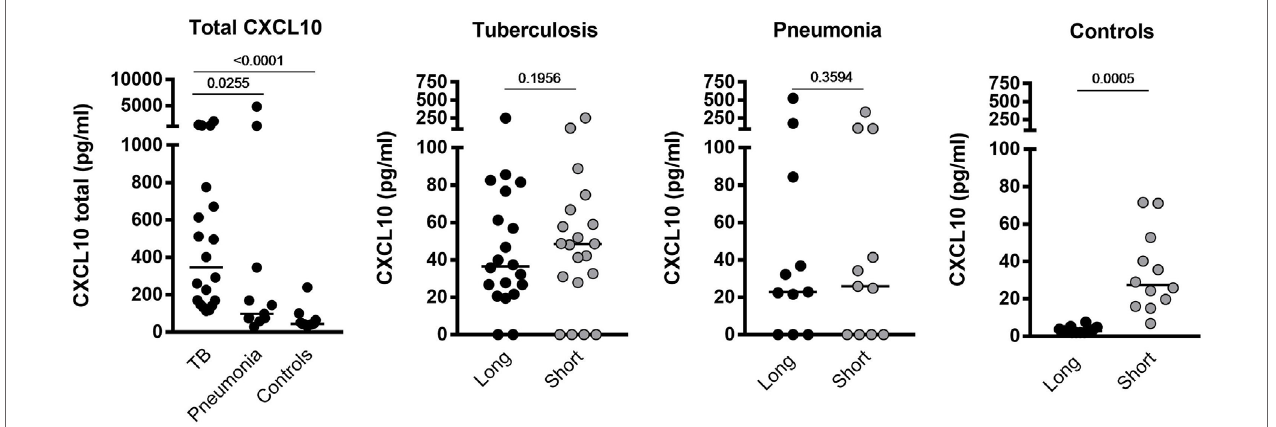
FigUre 1 | Plasma levels of CXCL10 total , CXCL10 long , and CXCL1010 short in samples from tuberculosis (TB) patients, pneumonia, and healthy controls.